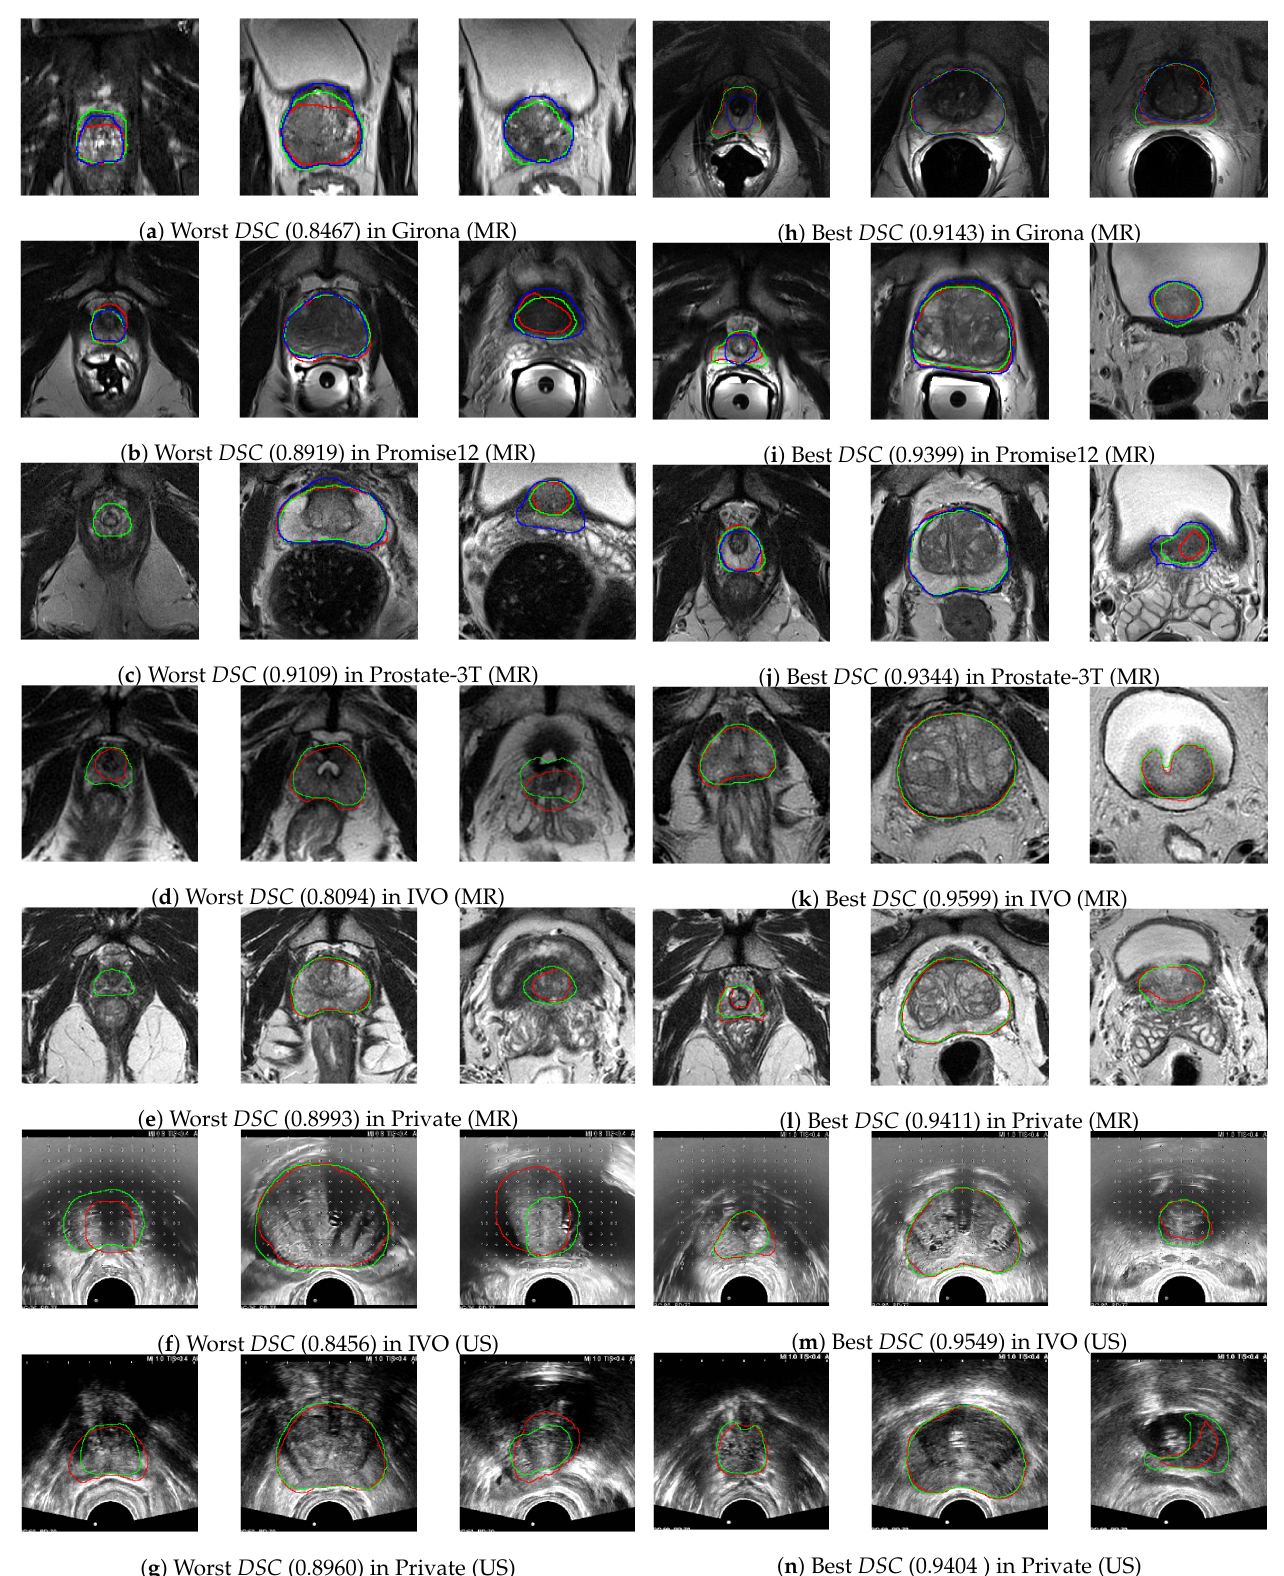
Figure 6. Worst ( left ) and best ( right ) segmentations in terms of DSC for each dataset (green: model, red: GT, blue: